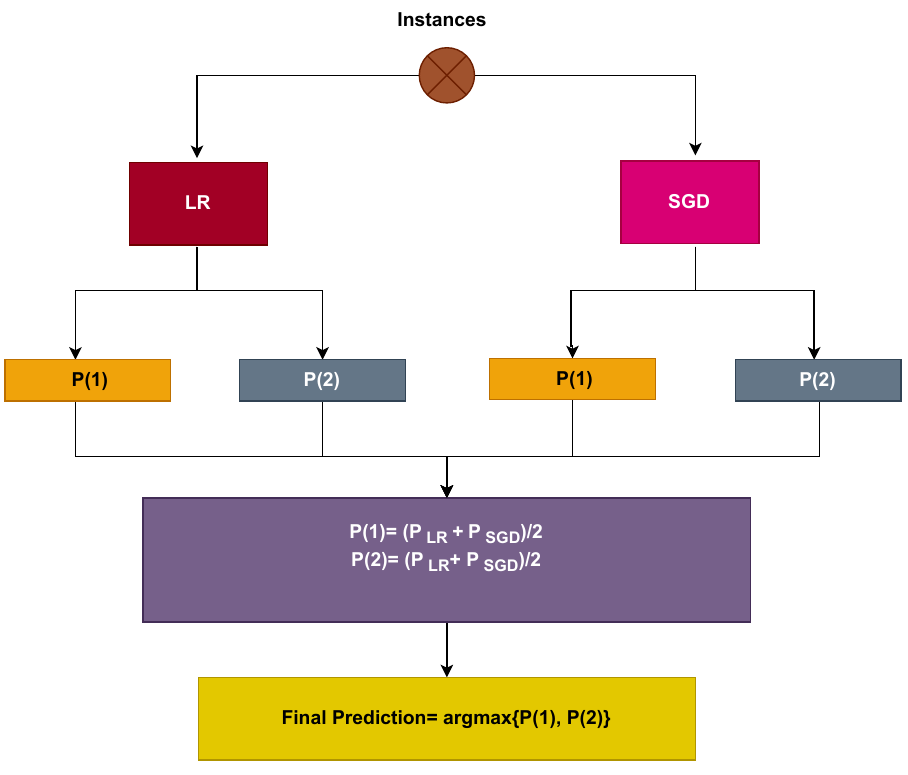
Figure 3. Architecture of the proposed voting classifier (LR+SGD)